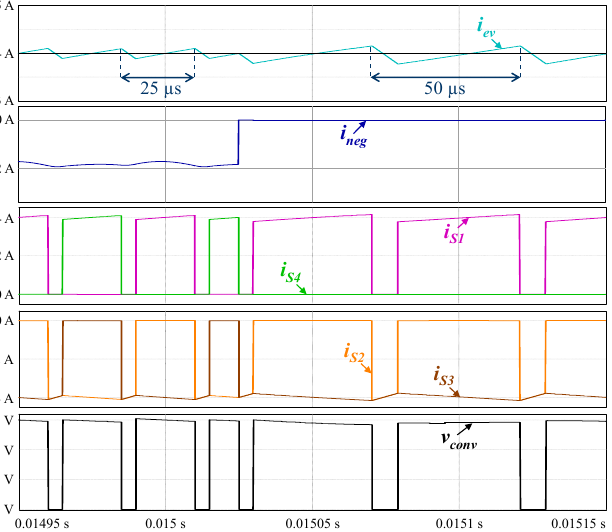
Figure 8. Waveforms of the EV current ( i ev ), dc grid current in the positive wire ( i pos ), currents in the IGBTs S 1 , S 2 , S 3 , S 4 ( i S 1 , i S 2 , i S 3 , i S 4 ), and voltage produced by the dc–dc converter ( v conv ) during the transition from normal operation to operation with a failure in the negative wire of the bipolar dc grid.